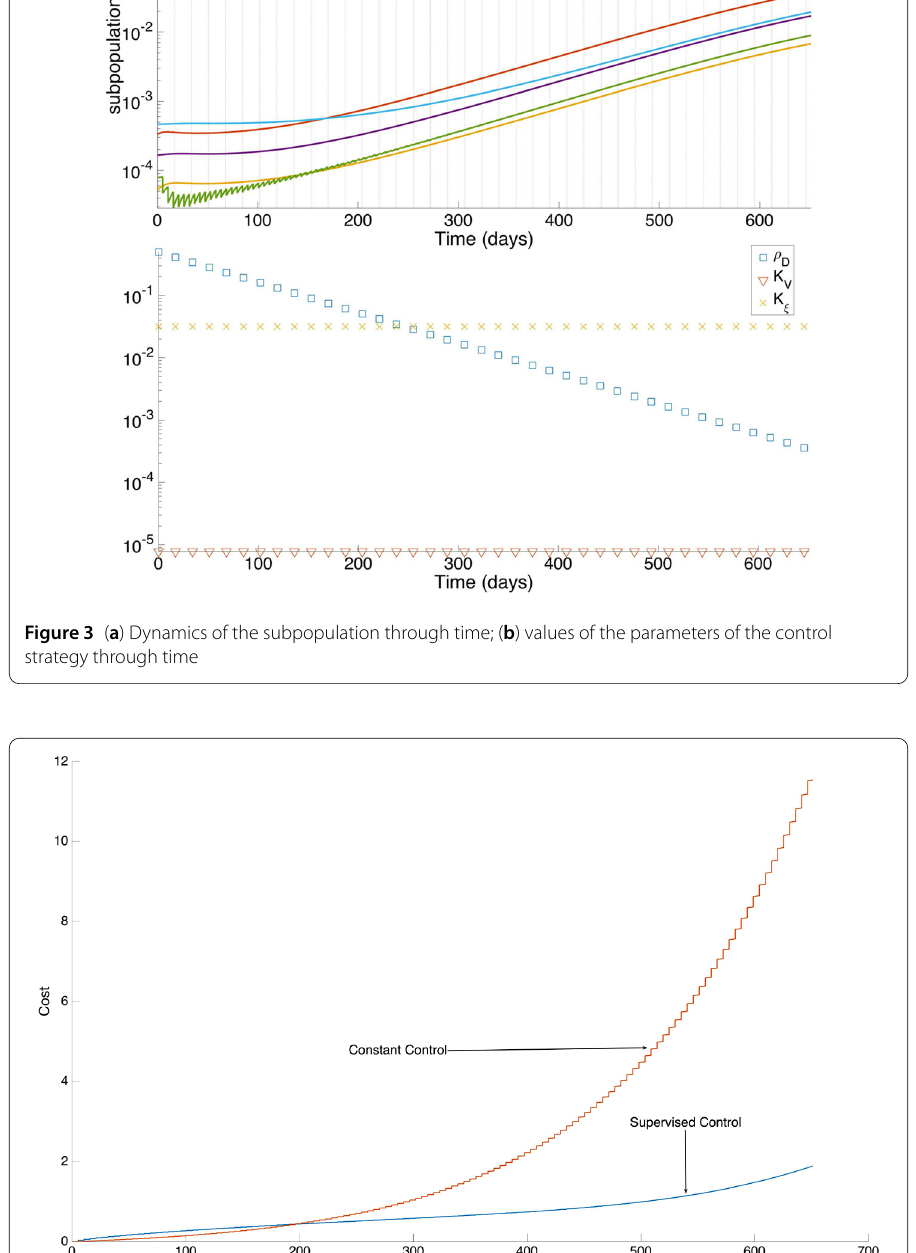
which the control remains constant and equal to the mean value of the values. We can see in Fig. 4 how the constant control ( ρ D = 0.074) presents a cost much higher than the supervised